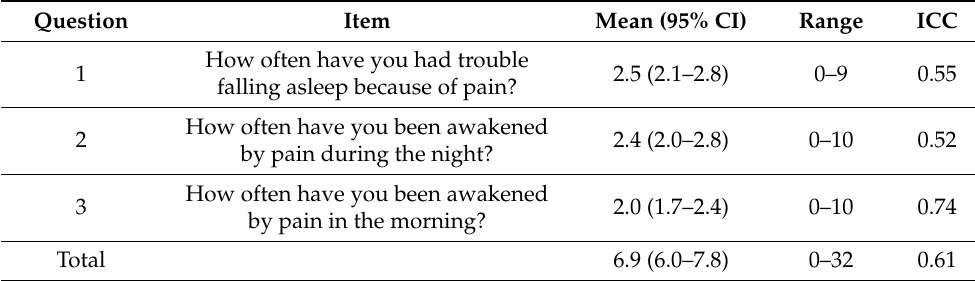
Table 1. Mean Pain and Sleep Questionnaire three-item index (PSQ-3-FI) scores.